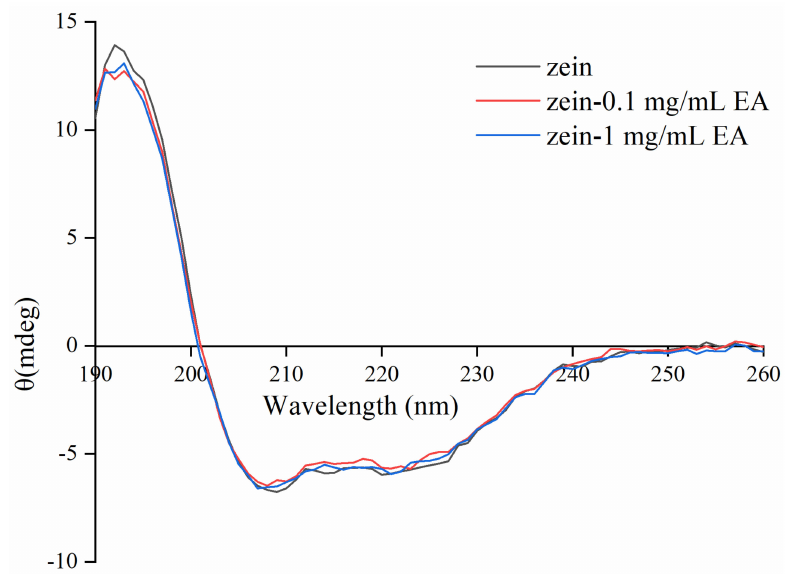
Figure 5. Effect of EA on the circular dichroism spectroscopy of zein. Note: EA: ellagic acid; the concentration of zein is 0.05 mg/mL; zein − 0.1 mg/mL EA: 0.05 mg/mL zein reacted with 0.1 mg/mL EA; zein − 1mg/mL EA: 0.05 mg/mL zein reacted with 1 mg/mL